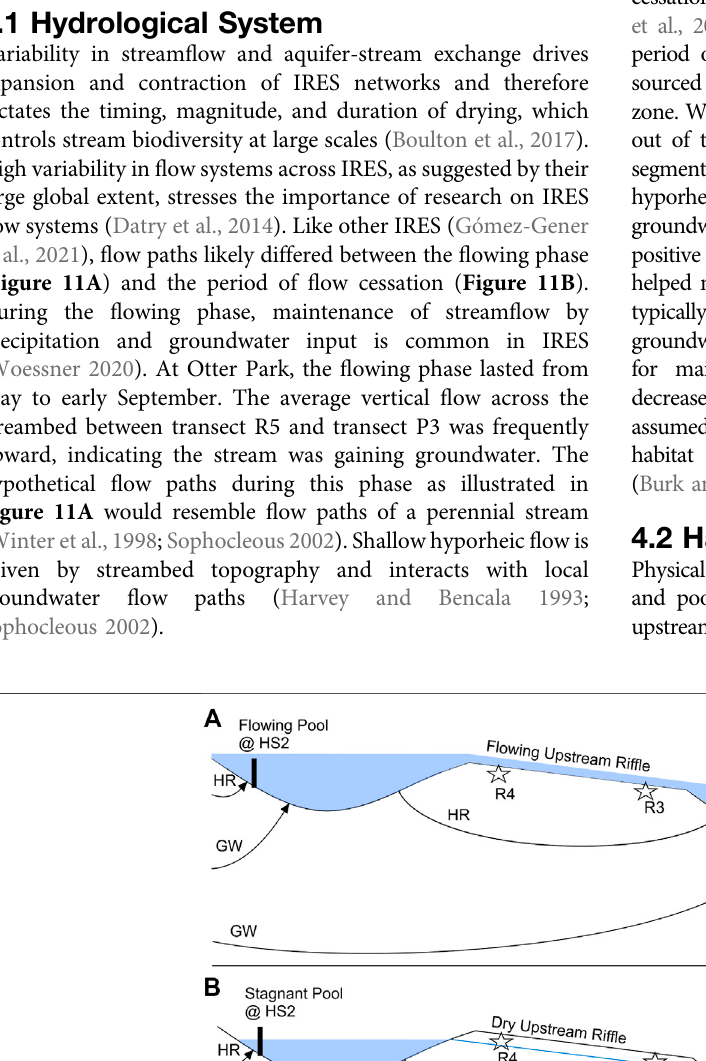
Frontiers in Earth Science |